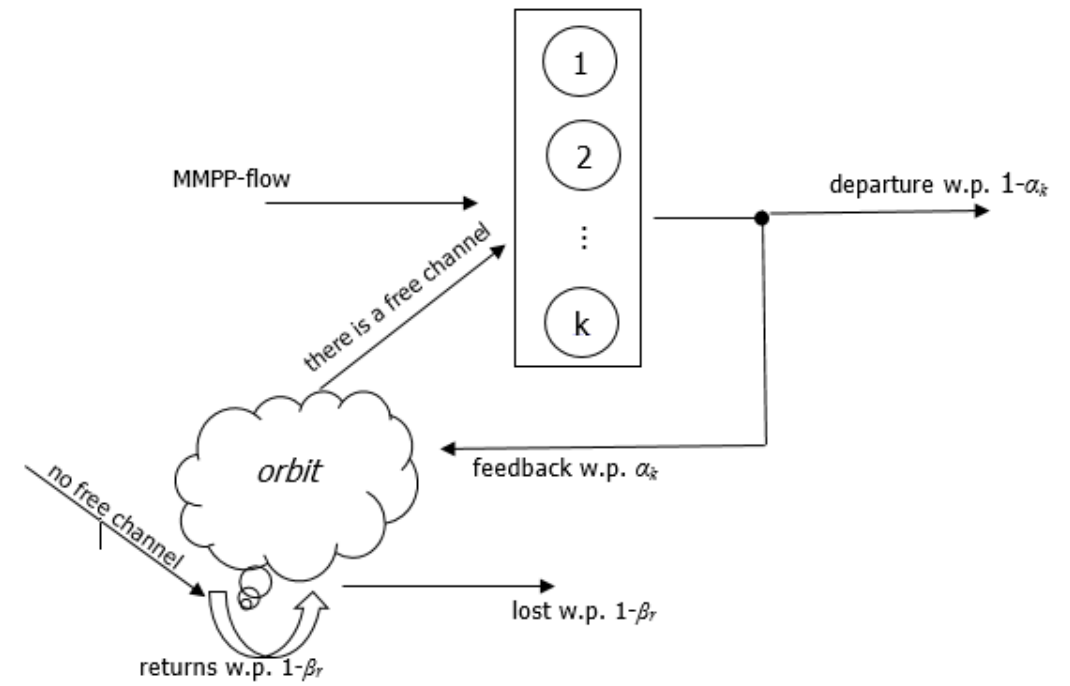
/ M / K / K with delayed